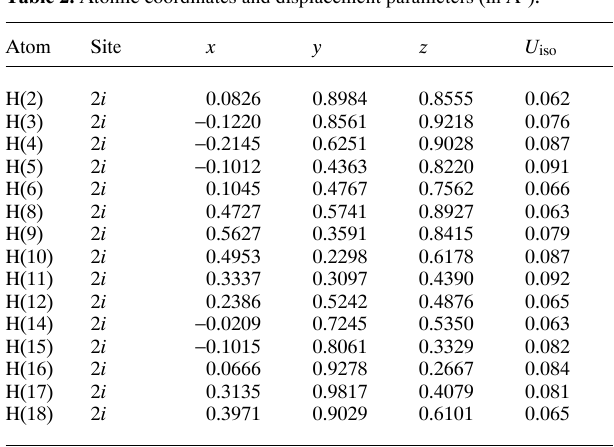
Table 2. A tomic coordin a tes a nd displ a cement p a r a meters (in Å 2 )